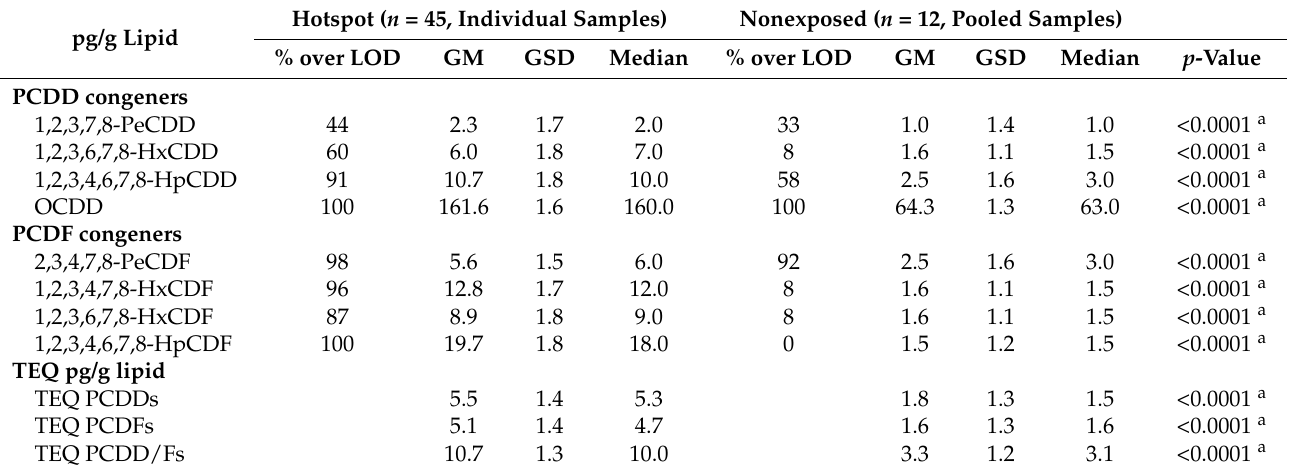
Table 1. Dioxin levels in serum of children in the hotspot and the nonexposed